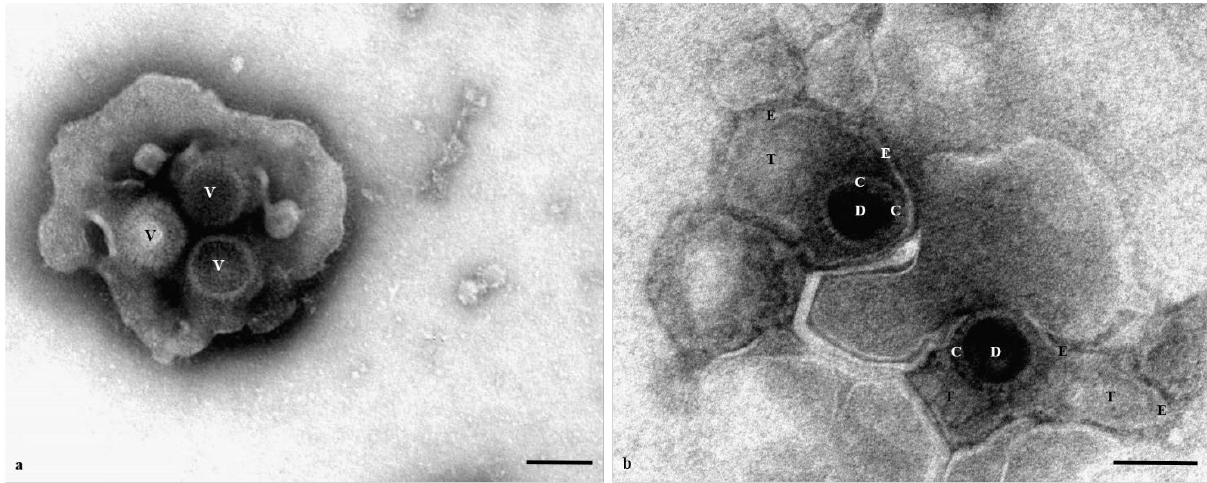
Figure 5. Negative-staining electron microscopy micrographs of herpesvirus particles (at 71k× magnifications). Bars = 100 nm. ( a ) Three non-enveloped virions ( V ) showing icosahedral nucleocapsid with distinct capsomers. Take note of the stain penetrated in the central hole of the capsomers. ( b ) Two enveloped particles with stain penetrated nucleocapsids. Take note of the representative four-layered structure of the virions: Core (DNA genome) ( D ); Capsid ( C ); Tegument ( T ) and Envelope ( E ).